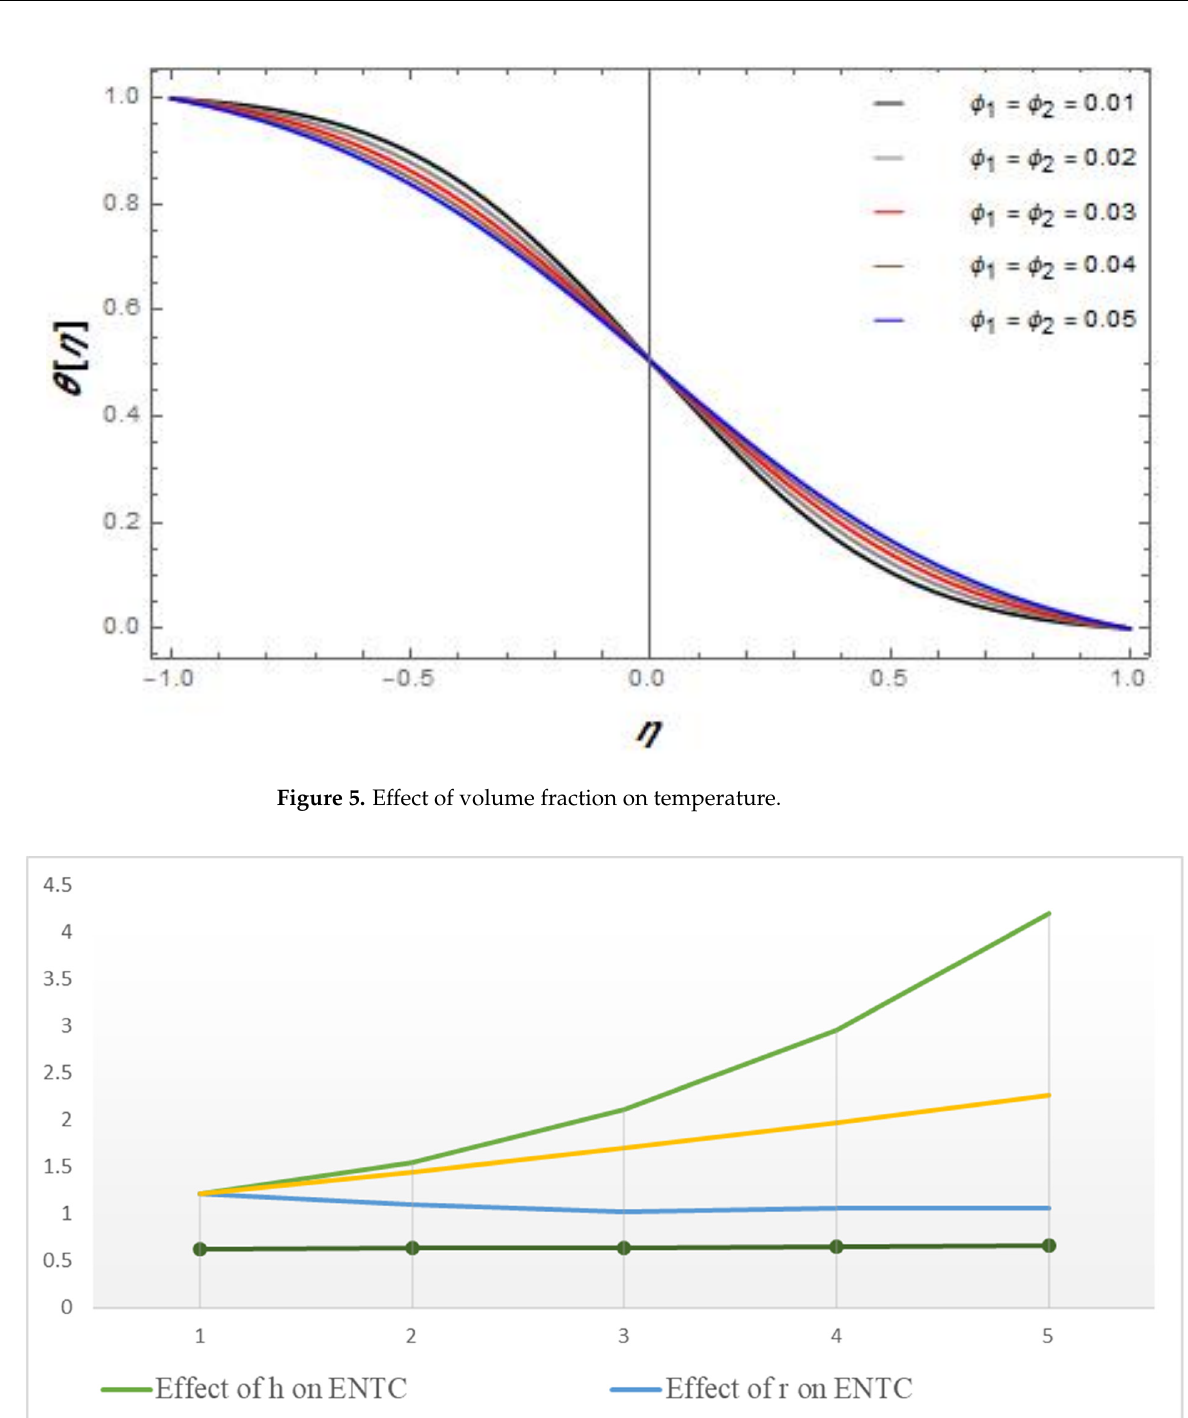
Figure 4. Effect of nanolayer thickness on the temperature profile.